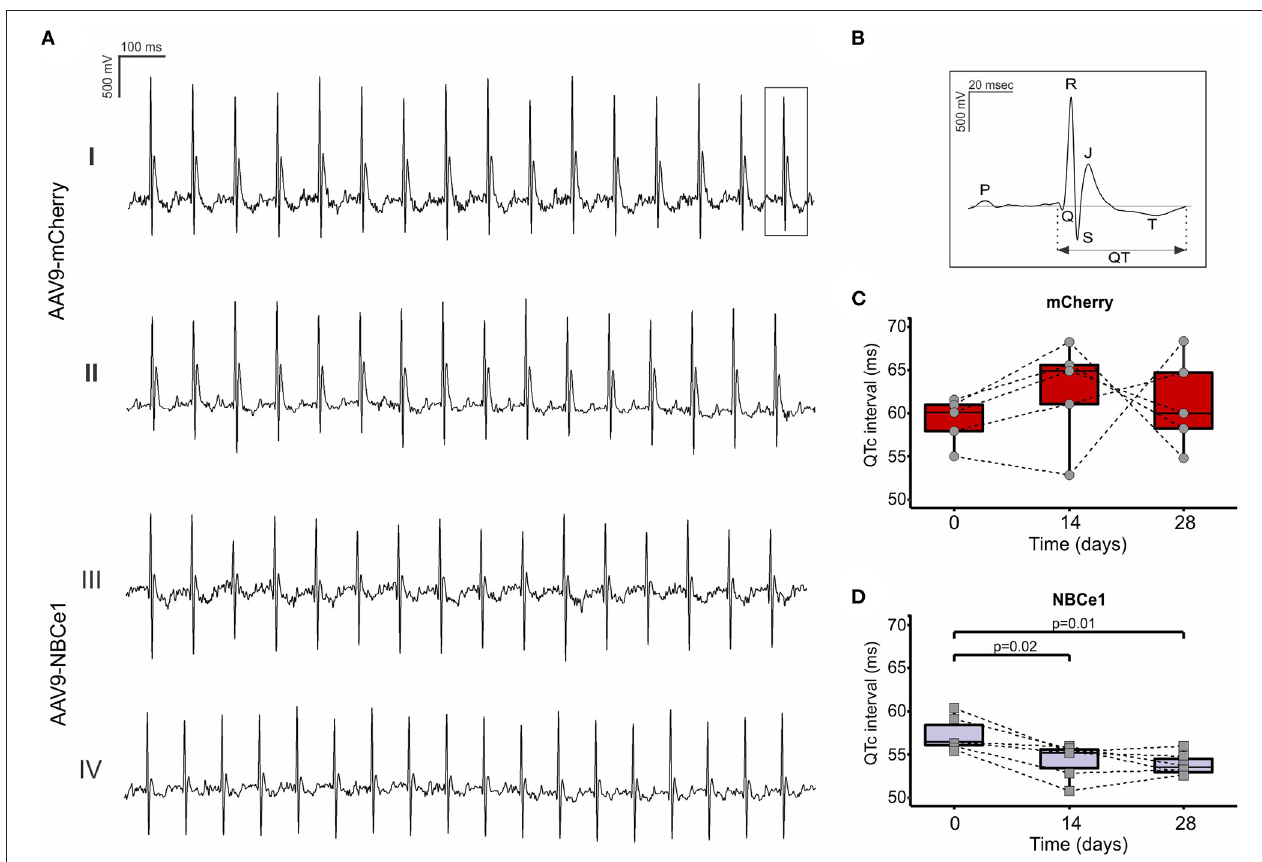
FIGURE 3 | (A) Representative electrocardiogram (ECG) recordings of mice before (I) and 28 days after (II) AAV9-mCherry or AAV9-NBCe1 transduction (III) and (IV). (B) Representative surface electrocardiography (ECG) curves showing QT interval. QTc (QT interval corrected with frequency) follow-up of the mice 14 and 28 days after injection with AAV9-mCherry (C) and AAV9-NBCe1 (D) . The QTc interval was significantly shorter in AAV9-NBCe1-injected mice. Statistical analysis was done by t -student test after Shapiro–Wilk normality test, p < 0.05 was considered significantly different. Black dashed lines connect the same animals at time 0, 14, and after 28 days. Boxes correspond to upper and lower quartiles, the horizontal line represents the median, and the whiskers mark the minimum and maximum values.